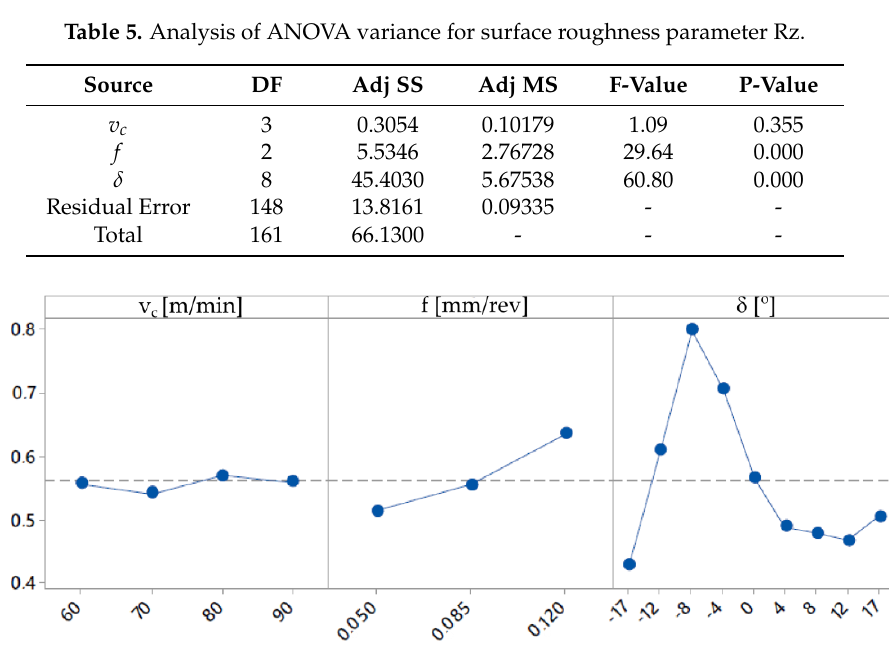
Figure 7. Graphs representing the relation between the surface roughness parameter Ra and the cutting speed v c , feed rate f and tilted angle δ .